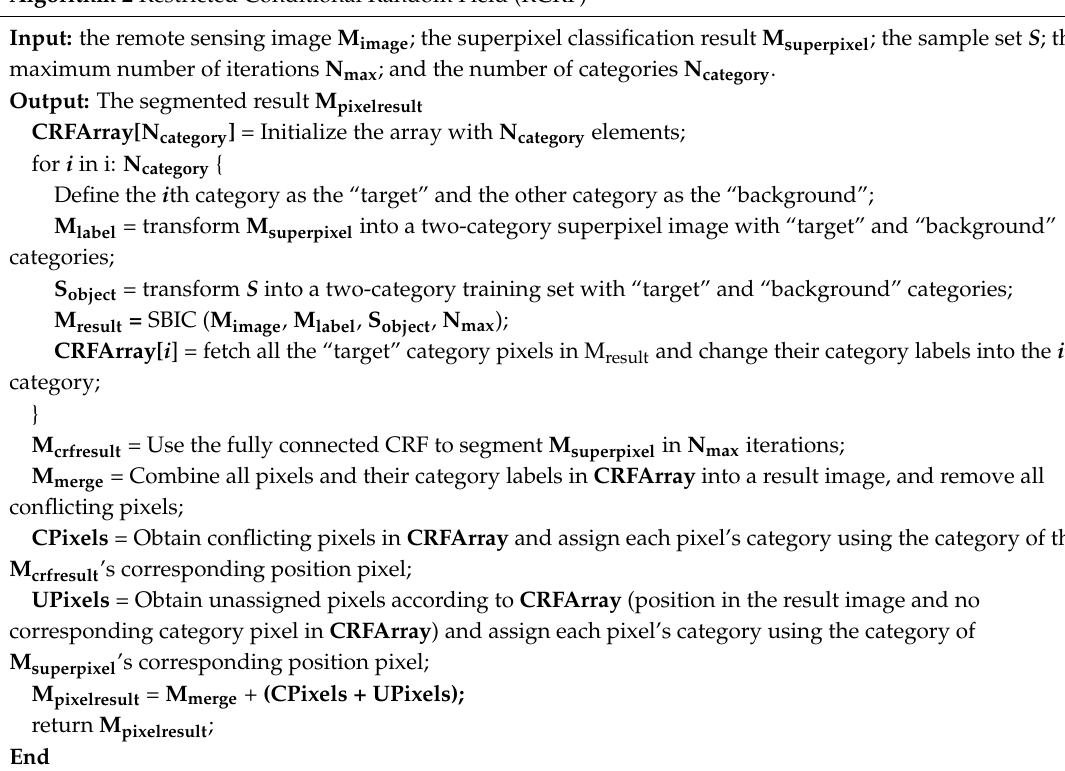
Algorithm 2 Restricted Conditional Random Field